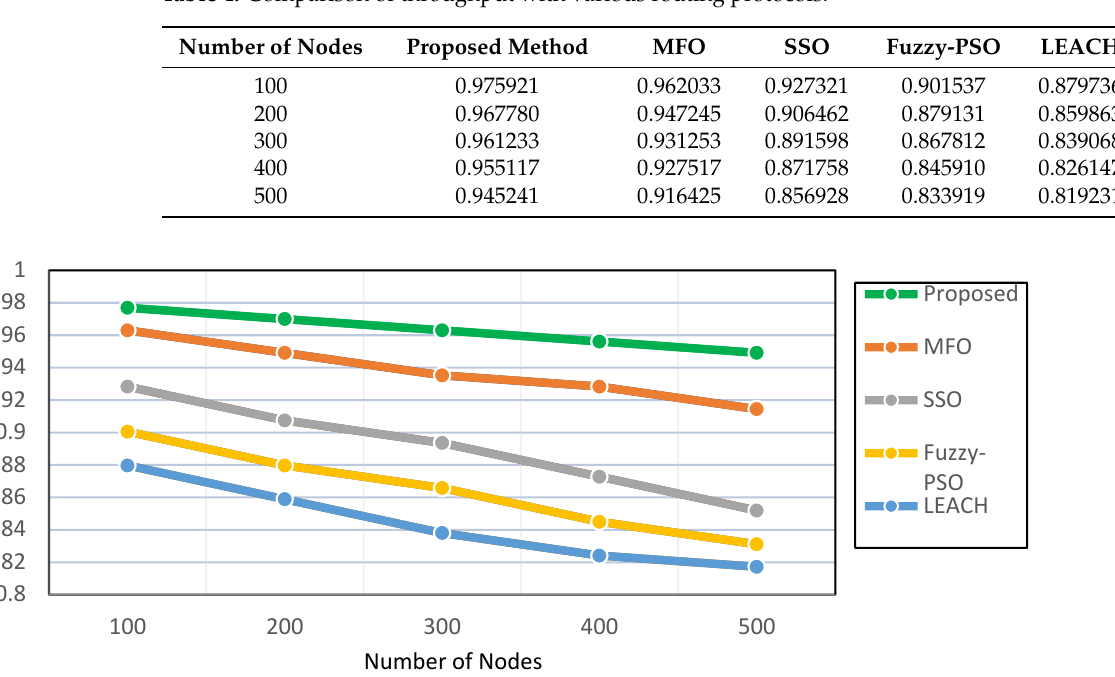
Figure 5. Analysis of End-to-End delay vs. number of nodes. (iv) Latency Latency is time required to transmit data in a network between the source and SN. It is also used to estimate round-trip time and the comparison of the obtained latency value is plotted in Figure 6 and tabulated in Table 6. Figure 6 shows that latency value ranges between 3 to 5 s, which is found to be the lowest when compared with other protocols. The LEACH method shows the highest latency value even for a fewer number of nodes. The Fuzzy-PSO shows some marginal differences. Here, the proposed routing approach achieved latency of 0.712 s, 2.23 s, 3.91 s, and 5.19 s in comparison to MFO, SSO, Fuzzy- PSO, and LEACH, respectively for 100 nodes. The highest latency difference of about 7.03 s is obtained for 500 nodes. Table 6. Comparison of latency with various routing protocols. Number of Nodes